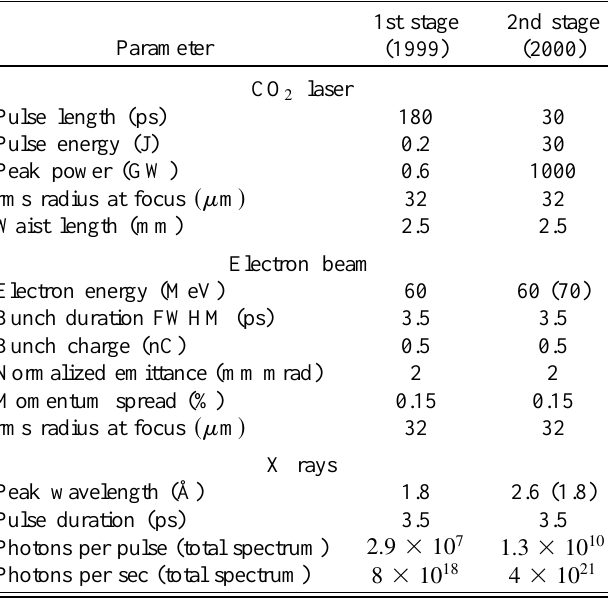
TABLE I. ATF CO 2 LSS experimental results and near-future design